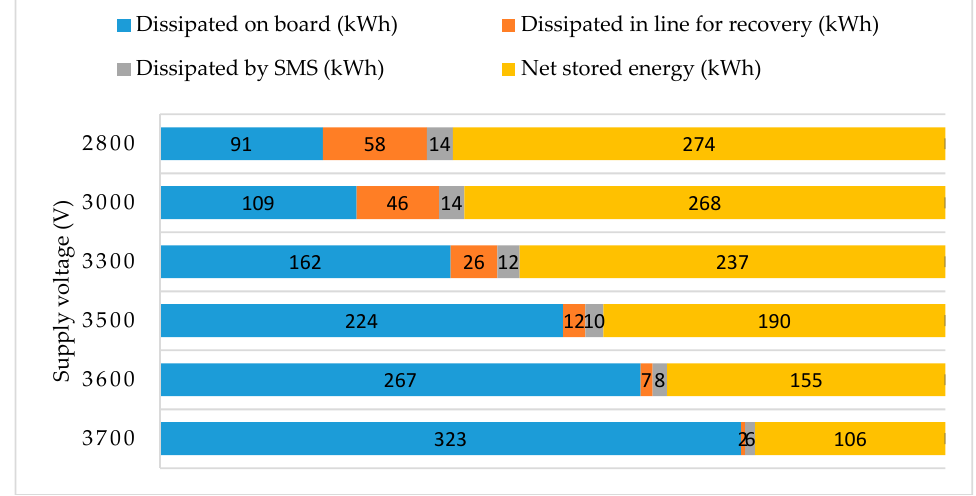
Figure 6. Energy analysis with a stationary ESS in Forlì on varying the supply line voltage.